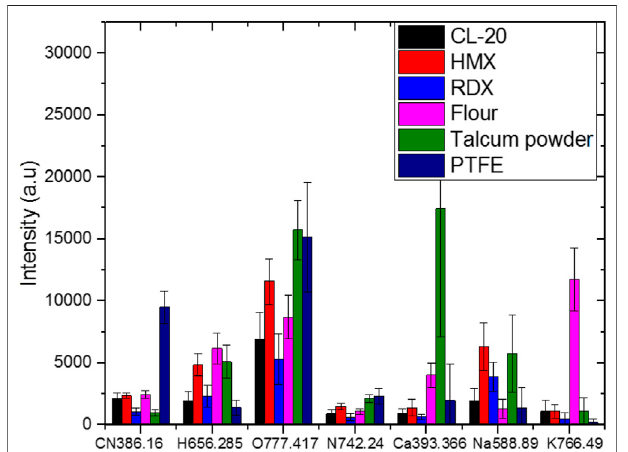
FIGURE 3 | Intensity of different lines and their standard deviation.